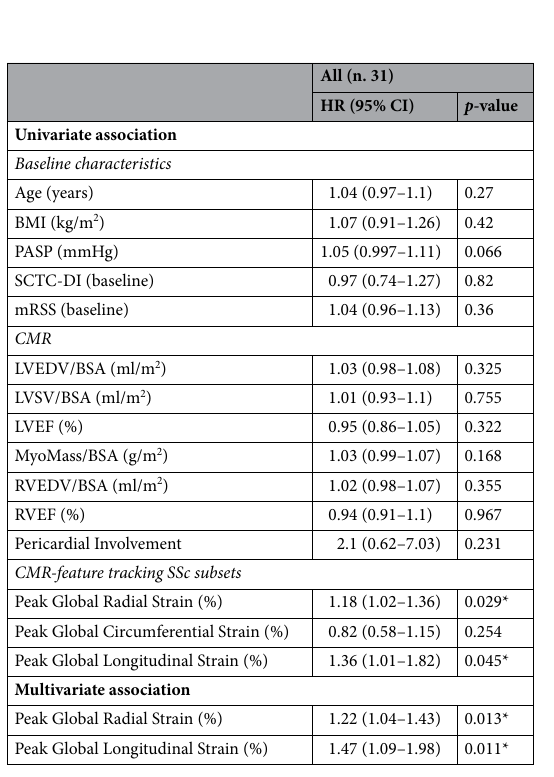
Table 4. Regression analysis for association with damage accrual. BMI: body mass index; PAP: pulmonary artery pressure; SCTC-DI: Scleroderma Clinical Trial Consortium Damage Index; mRSS: modified Rodnan Skin Score; CMR: cardiac magnetic resonance; LVEDV: left ventricular end-diastolic volume; BSA: body surface area; LVSV: left ventricular systolic volume; LVEF: left ventricular ejection fraction; MyoMass: myocardial mass; RVEDV: right ventricular end-diastolic volume; RVEF: right ventricular ejection fraction; SSc: systemic sclerosis. *significant test; p -value less than 0.05.